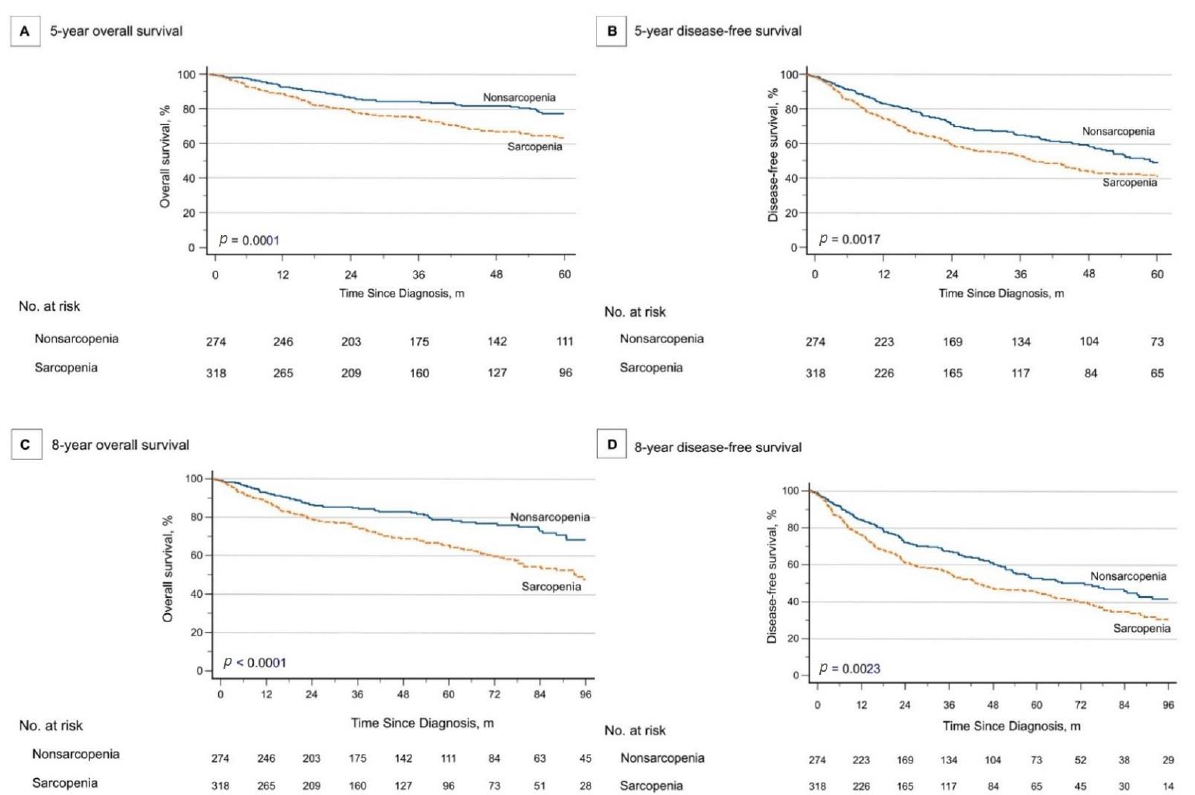
Figure 1. Survival of patients with and without sarcopenia: the 5-year overall survival ( A ), 5-year disease-free survival ( B ), 8-year overall survival ( C ), and 8-year disease-free survival ( D ) curves for patients according to sarcopenia status.